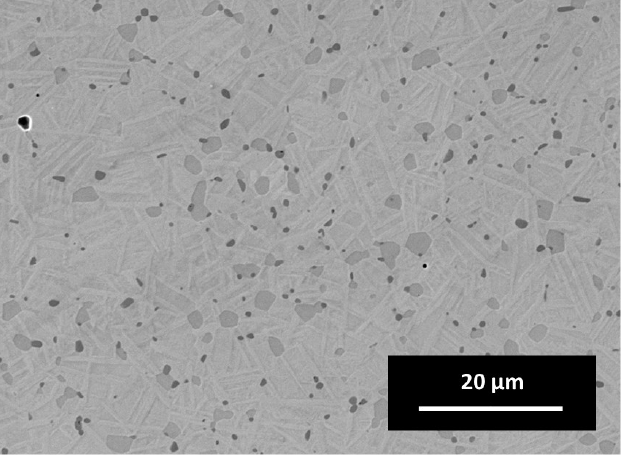
Figure 9. Microstructure of an as-sintered FFF sample using SEM; surface was not etched.